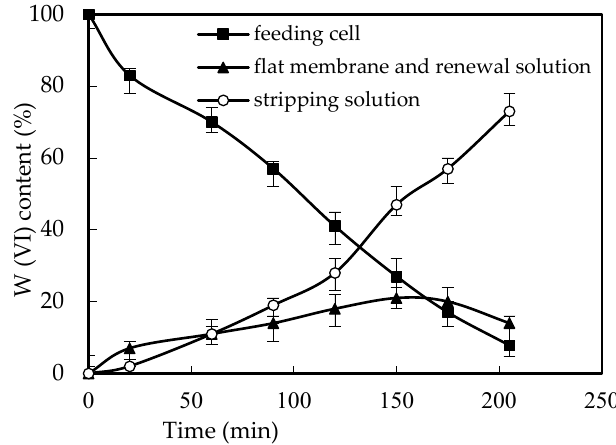
Figure 6. The retention of W (VI).